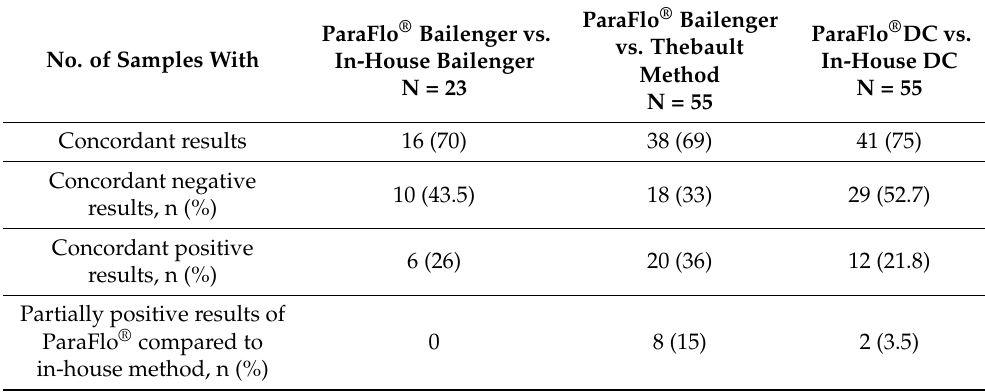
Table 2. Detailed results of in-house methods and ParaFlo ® methods, compared two by two. ParaFlo ® Bailenger No. of Samples With